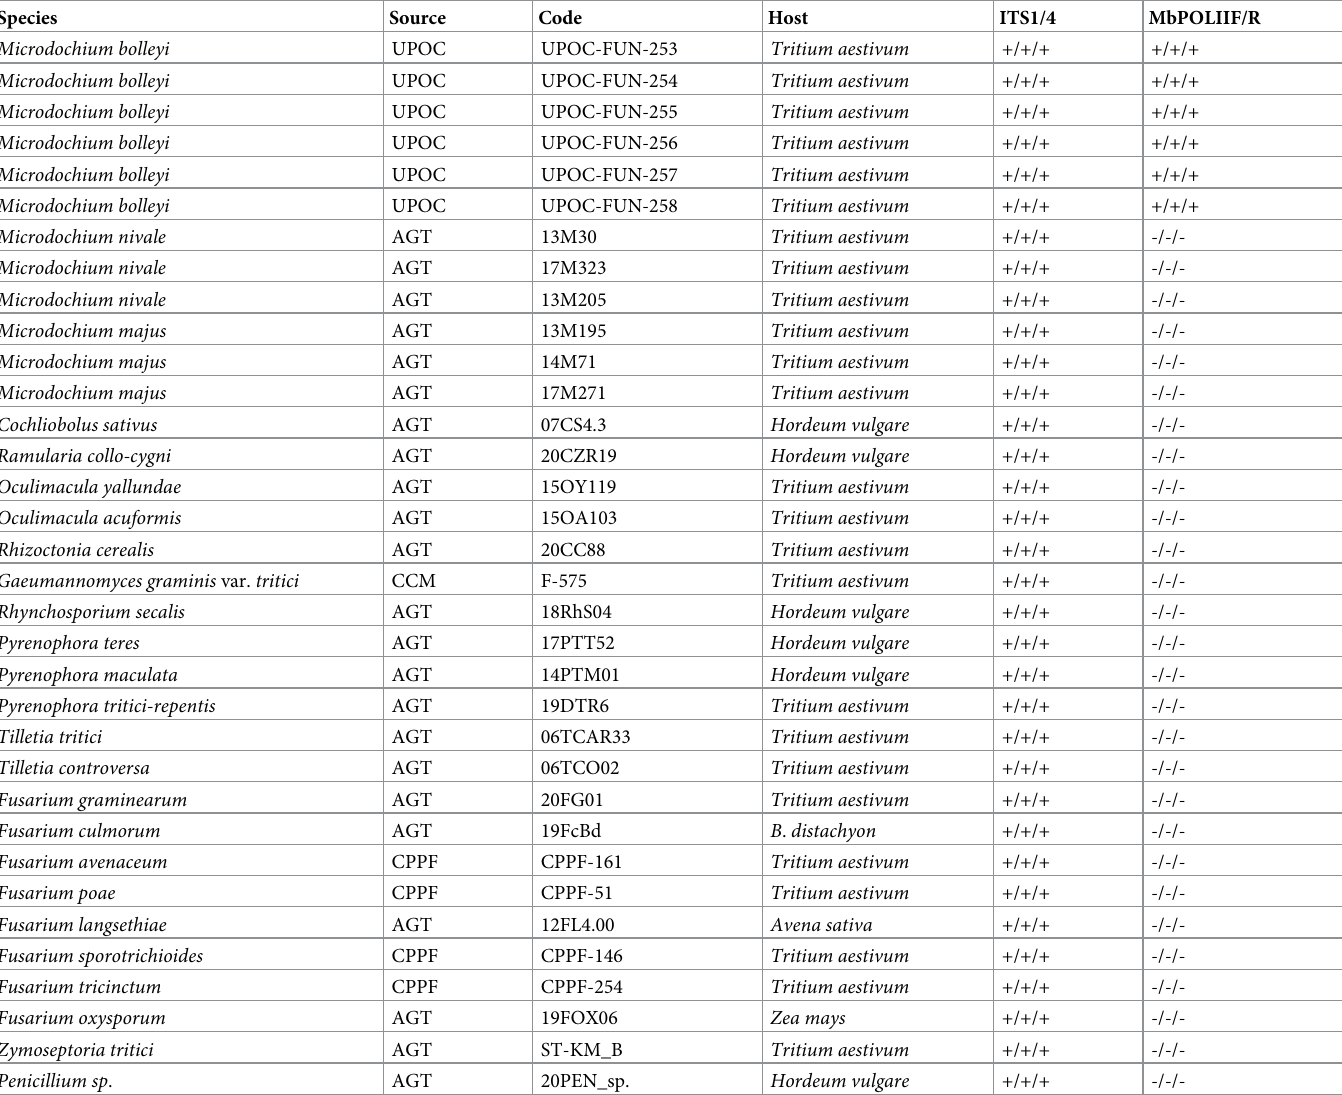
Table 1. Fungal species used in the analysis with MbPOLIIF/R primers designed in the current study. A positive reaction result distinguished by a visible band on the gel is indicated by a + sign, a negative response by a–sign. To confirm the presence of DNA, a control polymerase chain reaction (PCR) reaction with universal primers ITS1/ITS4 was performed on all samples. Reactions were always repeated three